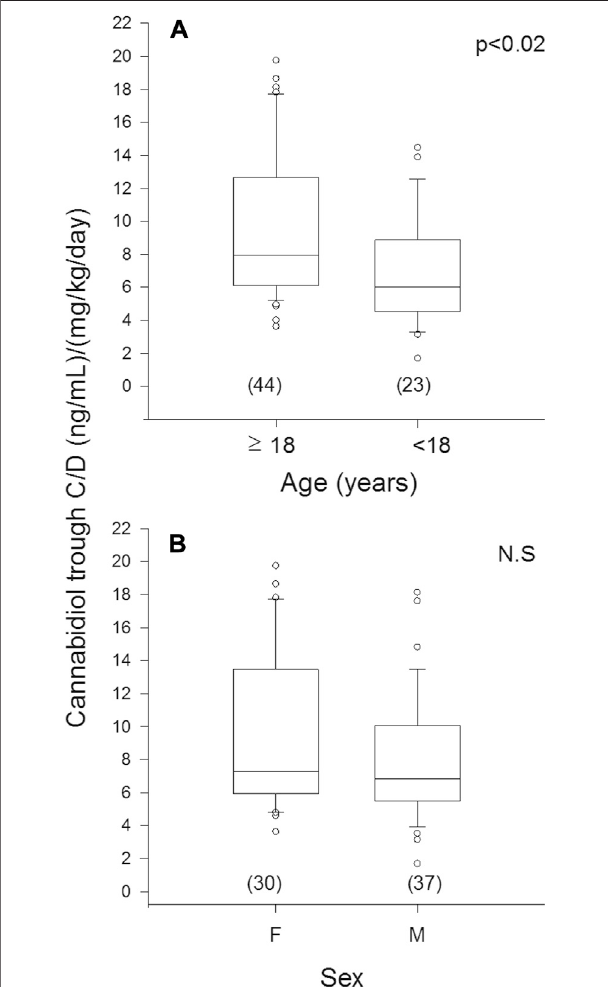
FIGURE 3 | Plasma concentration to weight-adjusted daily dose ratio of cannabidiol (C/D) from patients ’ specimens (n) grouped by age (A) and sex (B) . Box plots depict the range between the 25 th and 75 th percentiles of the data. The horizontal line marks the median value; capped bars indicate 10 th – 90 th percentiles.Blackcirclesrepresentoutlyingvalues. p ,signi fi canceof comparison between age and sex groups by Mann-Whitney rank sum test; N.S., not signi fi cant ( p ≥